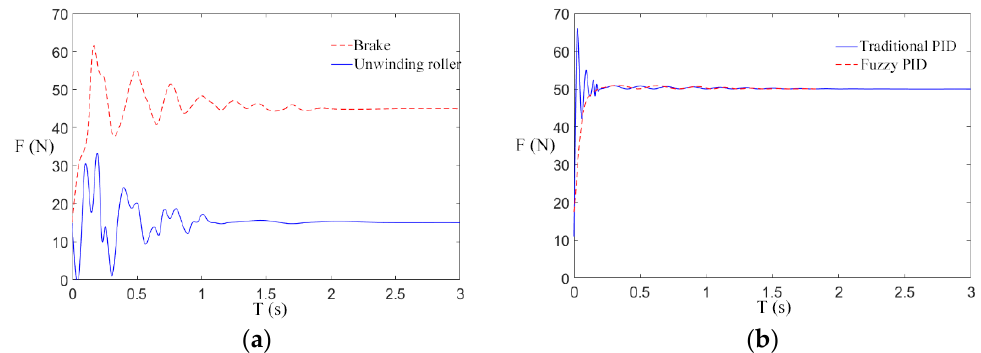
Figure 14. Tension response at 50 N reference tension. ( a ) Tension of unwinding roller and electro-